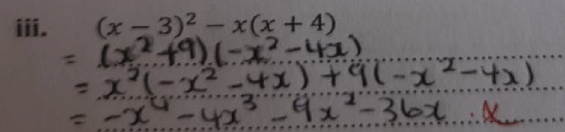
Figure 4: Experimental learner AX, School X.